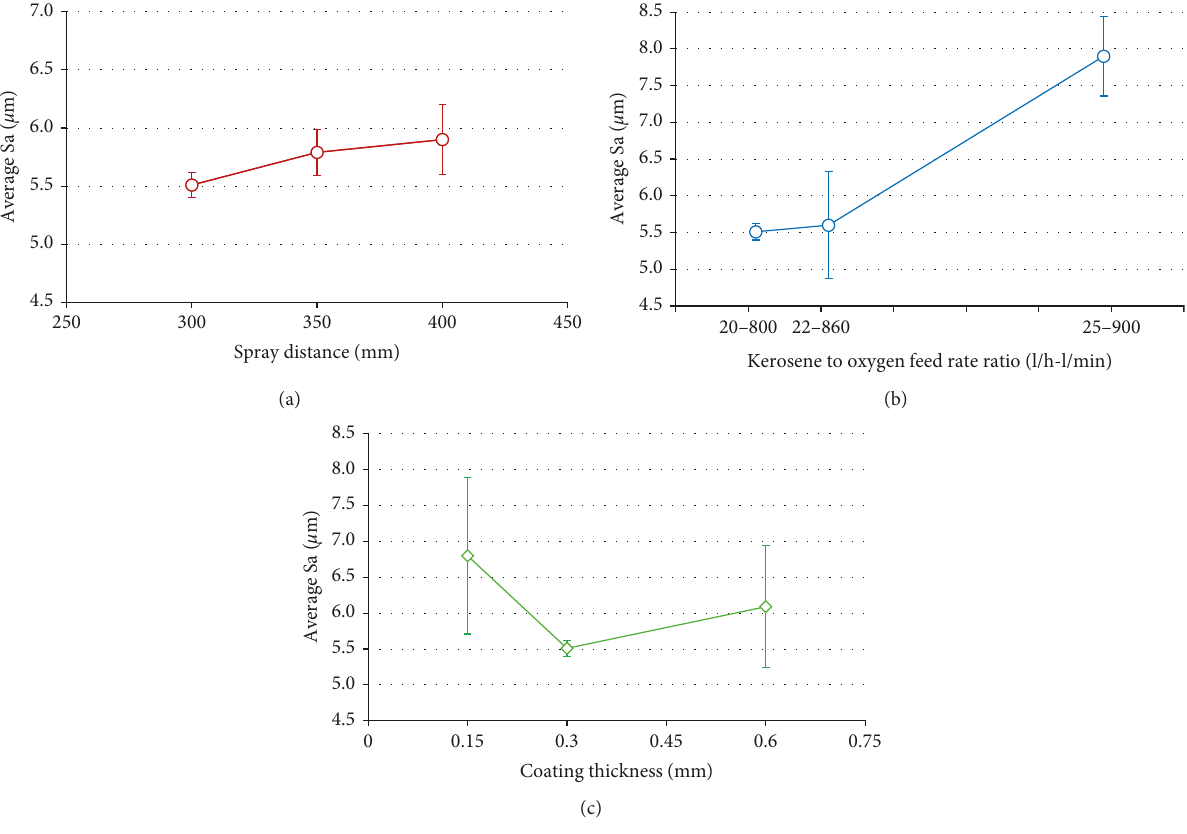
Figure 3: Effect of (a) spray distance, (b) kerosene to oxygen feed rate ratio, and (c) coating thickness on Sa roughness